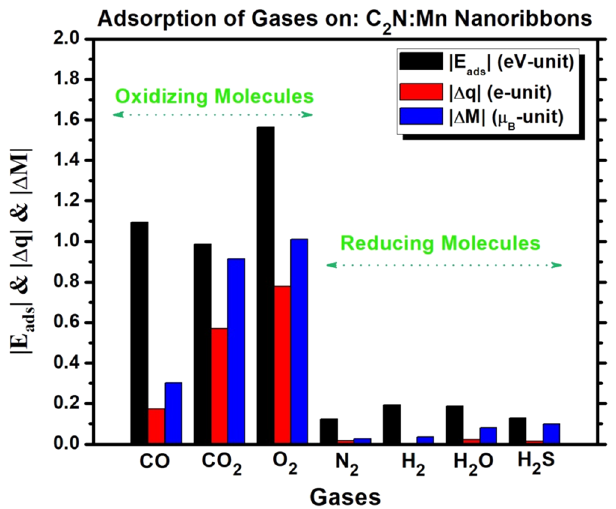
Figure. 7. Comparison of absolute values of adsorption energy (|E ads |), charge transfer (|Δq|) and variation of magnetization (|ΔM|) from before to after the adsorption of gas